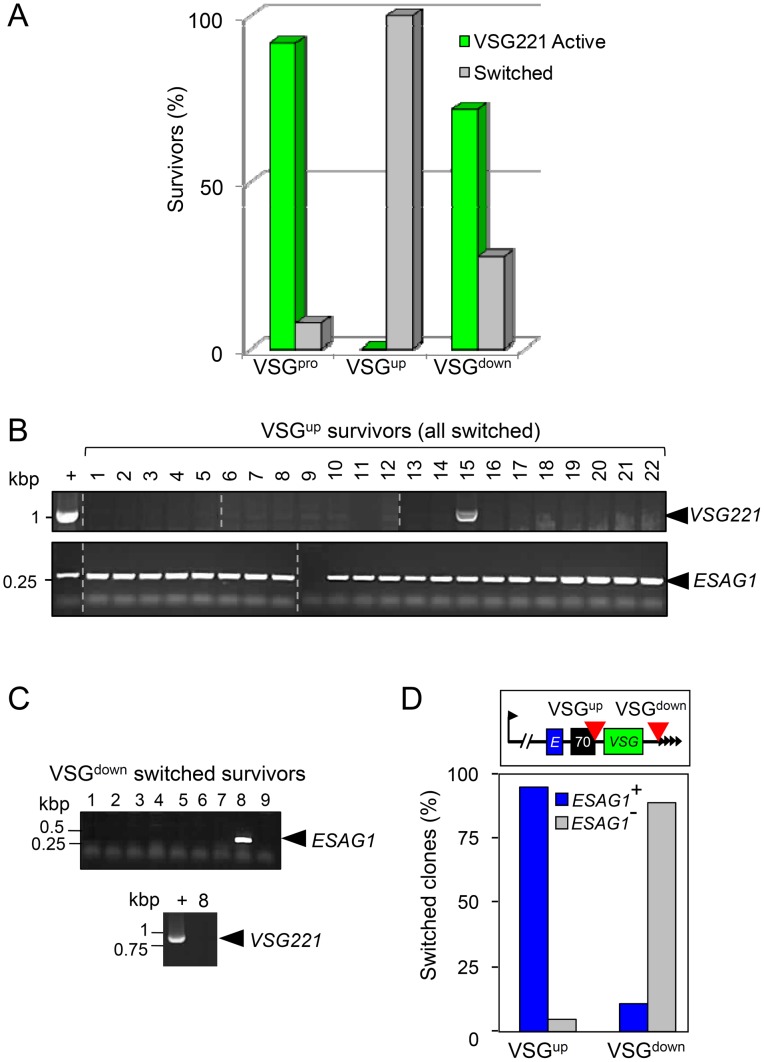
Probability and mechanism of antigenic variation are highly dependent upon subtelomeric break site.(A) DSB-induced survivors were assessed by VSG221 immunofluorescence microscopy and scored as either VSG221 active or switched. VSGpro, n = 24; VSGup, n = 22; VSGdown, n = 32. (B) PCR assays demonstrate VSG221 and ESAG1 gene status following I-SceI-mediated cleavage in switched survivors from VSGup cells. See the schematic maps in Figure 2A and Figure S2A for details. (C) As in B above but for VSGdown cells. (D) Comparison of ESAG1 status of switched survivors from VSGup (n = 22) and VSGdown strains (n = 9) as determined by PCR assay. The schematic shows the BES and DSB-sites, red arrowheads. E, ESAG1; 70, 70-bp repeats; VSG, VSG221.